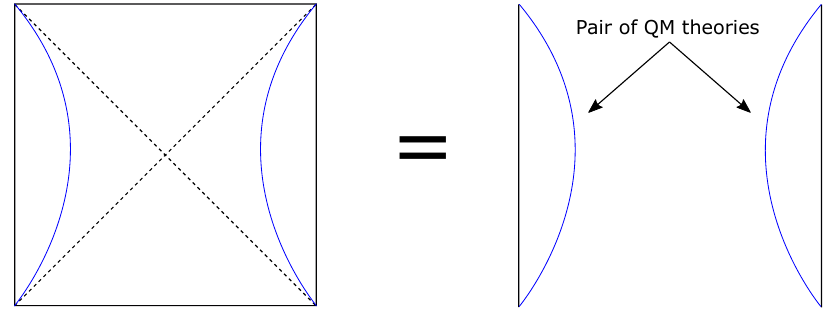
Figure 2 . The de Sitter region is replaced by a pair of quantum-mechanical theories, each described by a Hilbert space of e A/ 4 G degrees of